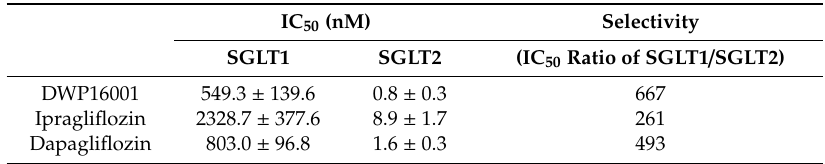
Data were expressed as mean ± SD from triplicate